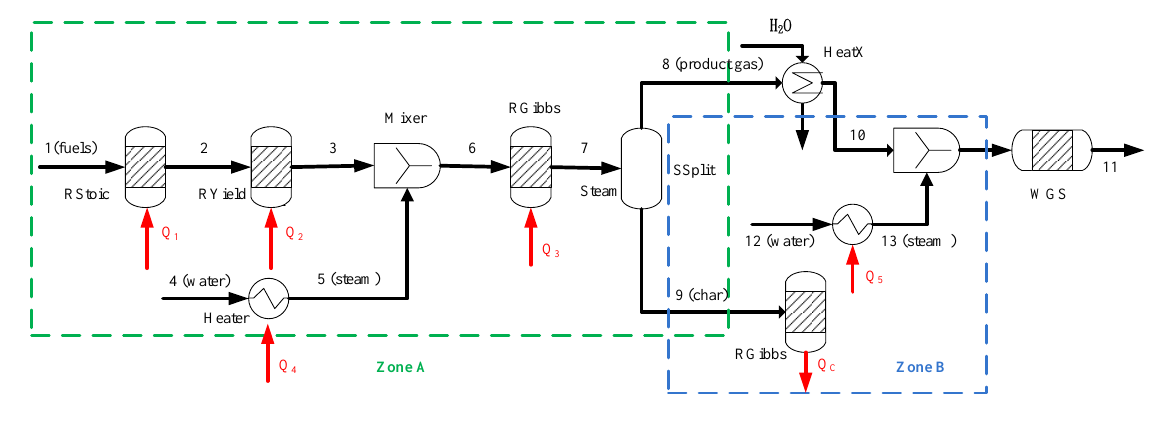
Figure 6. Flow chart of the steam gasification process with heat